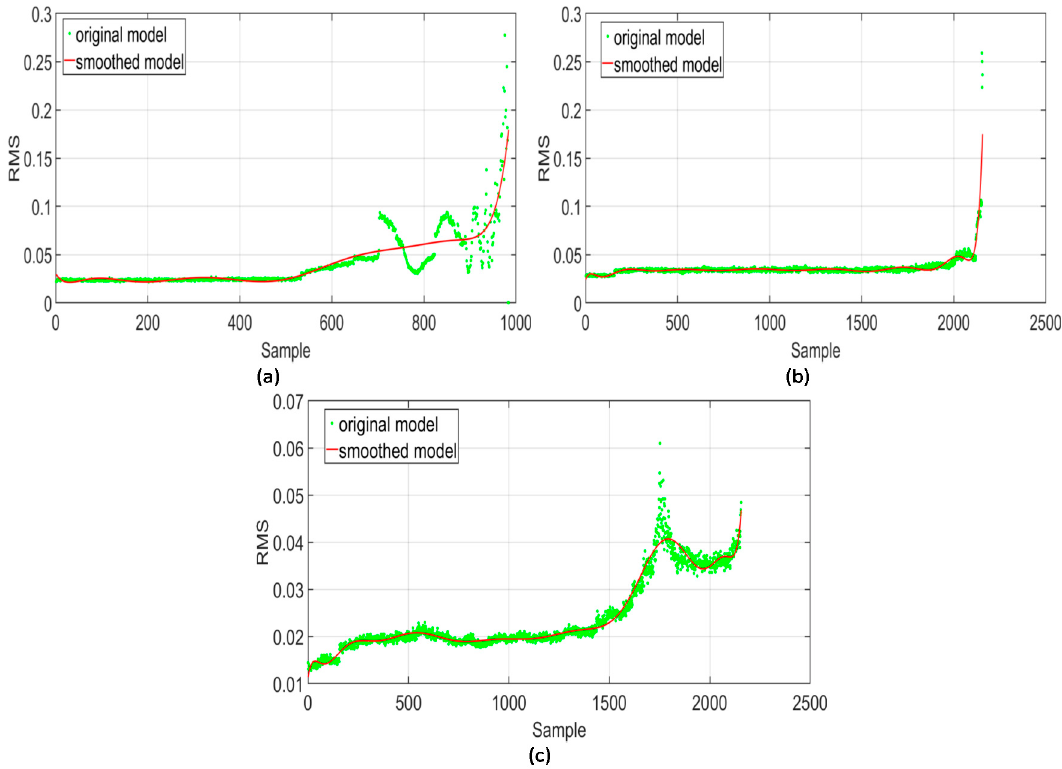
Figure 6. Effect of smoothing using locally weighted regression on the RMS trends of ( a ) bearing 1 of the second run-to-failure test, ( b ) bearing 3 of the first run-to-failure test, and ( c ) bearing 4 of the first run-to-failure test. The IMS dataset was used for these tests.